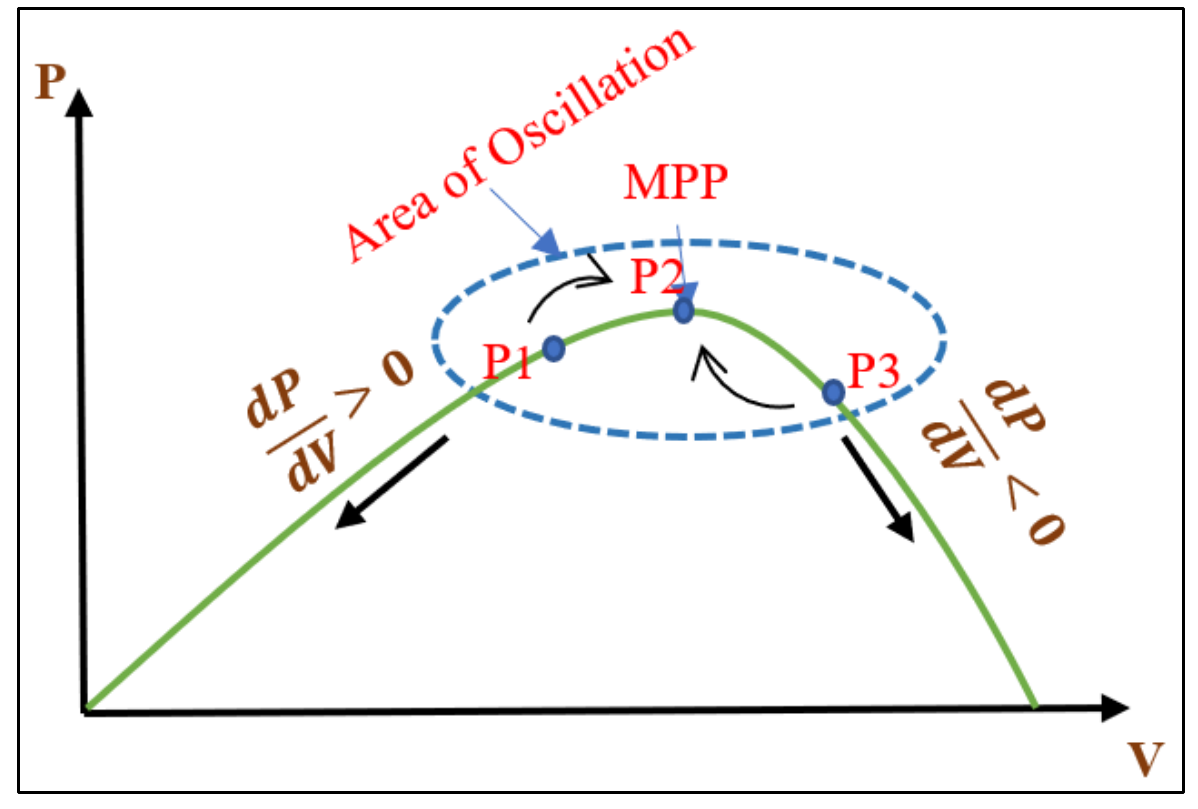
(cid:17) (cid:16) dP . Figure 7. Three-level operation of P&O technique with slope changes . dV 𝑑𝑑𝑑𝑑 � 𝑑𝑑𝑑𝑑 �